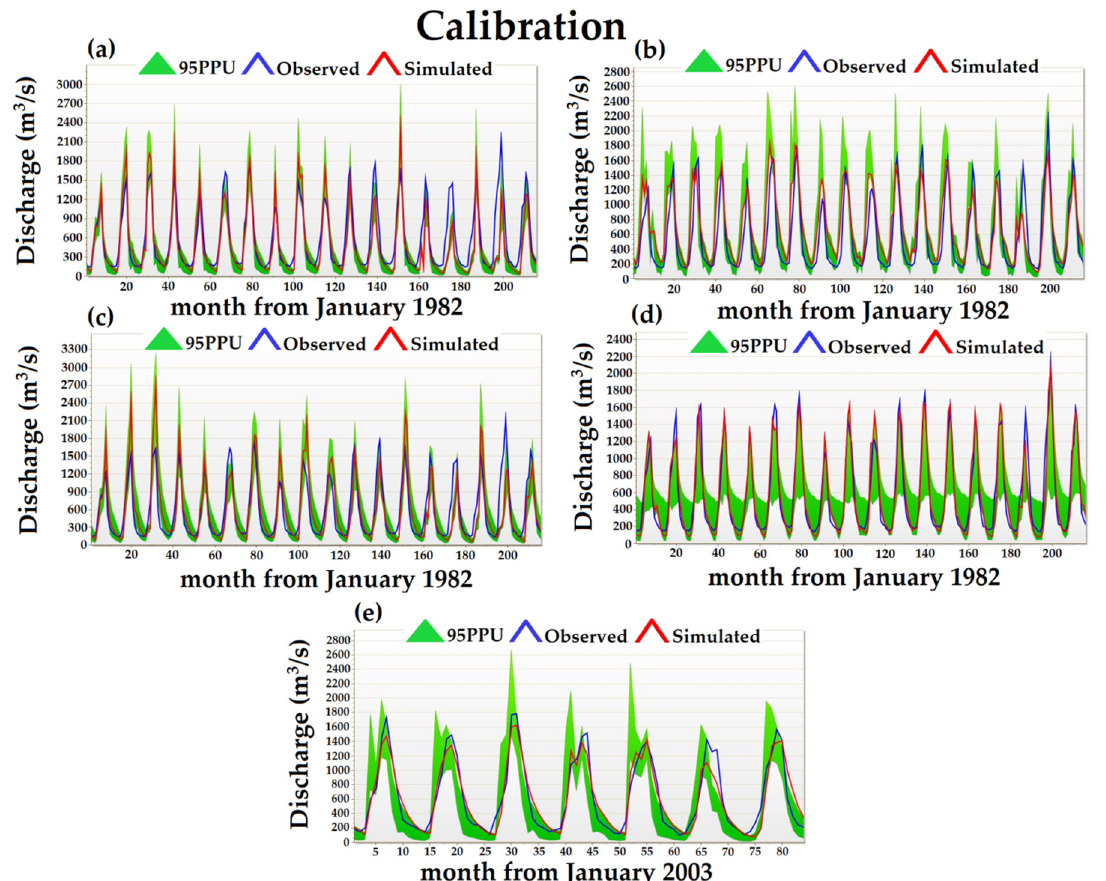
Figure 5. Hydrographic calibration between monthly observed and simulated streamflow, when applying the SWAT–CUP tool, at Darband gauging station in the Upper Vakhsh River Basin in Central Asia. ( a ) Results of the daily precipitation of the APHRODITE_V1101 and daily maximum/minimum temperatures from the CFSR datasets; ( b ) results of the daily precipitation of the APHRODITE_V1101 and daily maximum/minimum temperatures of the CRU TS3.1 product; ( c ) results of the daily maximum/minimum temperatures, precipitation, average solar radiation, average wind speed and relative humidity from the CFSR product; ( d ) results of the daily maximum/minimum temperatures, and precipitation from the CRU TS3.1 product; ( e ) results of the daily maximum/minimum temperatures and precipitation from the observational climate